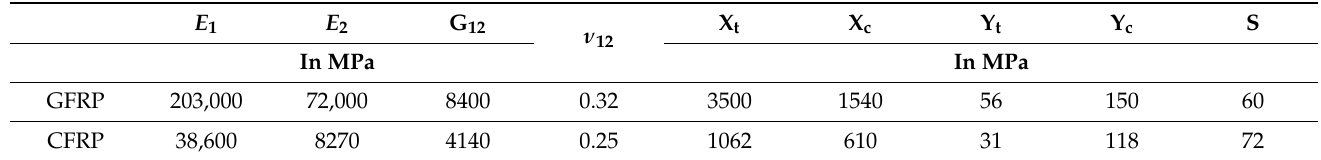
Table 1. Mechanical properties of